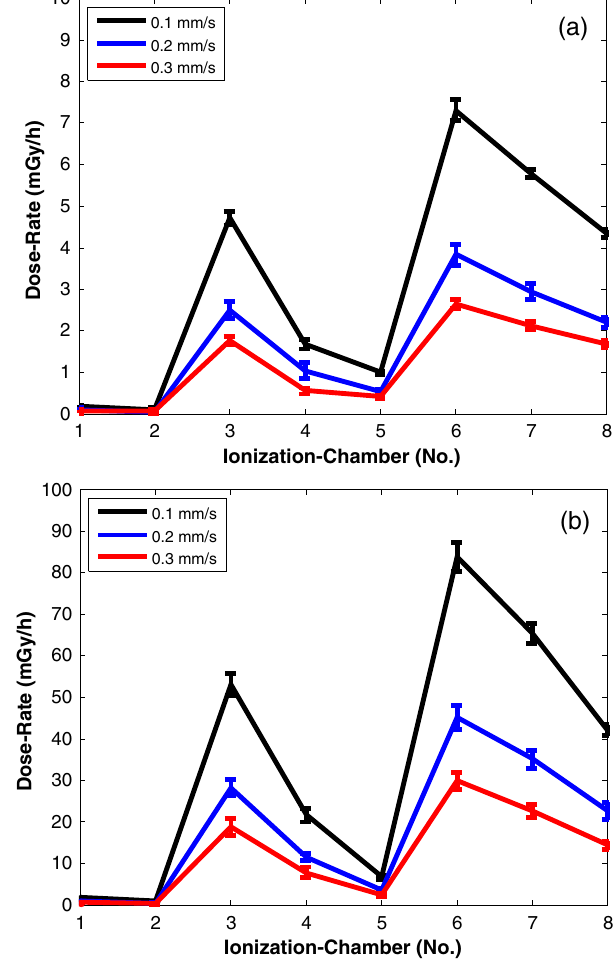
FIG. 19. Average radiation-dose rate (mGy = h) measured by the 8 ionization chambers (I-C) placed in the FERMI FEL1 undulator chain when scanning — with (a) a 12 . 5 μ m Al ð 99 Þ ∶ Si ð 1 Þ wire and (b) a 5 μ m tungsten wire — an electron beam of 700 pC and energy of 1.325 GeV at a motor speed of 0.10, 0.20 and 0 . 30 mm = s. The data in the plot are the result of the average of the I-C dose-rate readout over 10 beam with two homologous 12 . 5 μ m Al ð 99 Þ ∶ Si ð 1 Þ and 5 μ m tungsten wires are compared in Fig. 19 for different